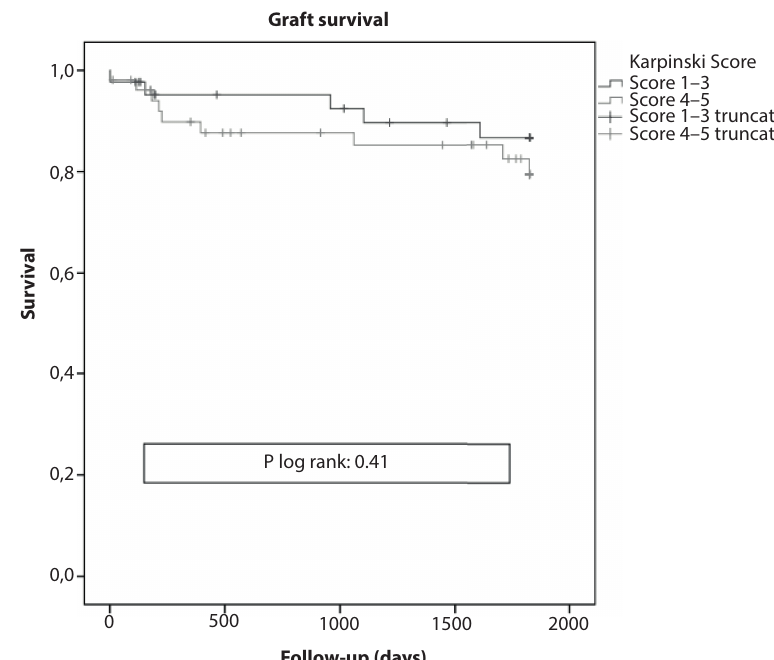
Figure 1: Kaplan–Meier curves for graft